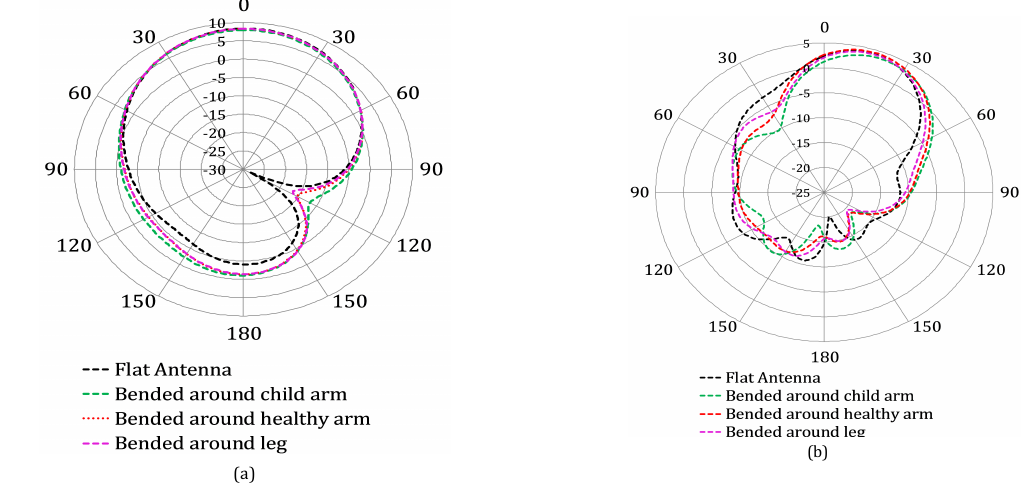
Figure 18. Off-body directivity patterns of the conventional dual band antenna at ( a ) 2.5 GHz and ( b ) 5.2